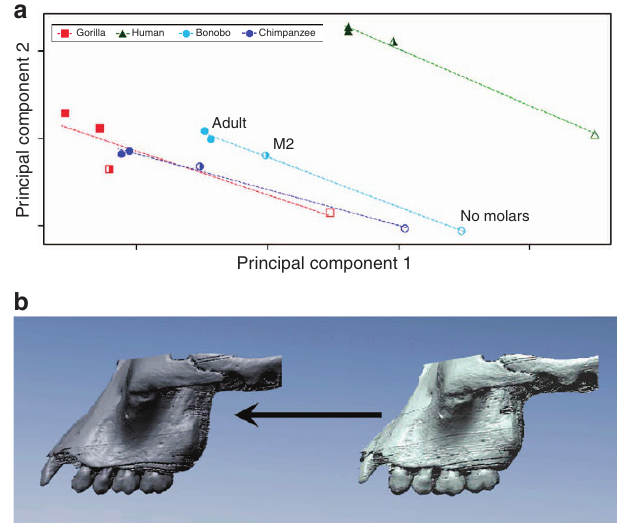
Figure 3 | Ontogenetic changes among the dentition, malar root and temporomandibular joint in 319 extant African apes and humans. ( a ) Principal component summary of shape differences, represented by mean configurations, among specimens with no molars (open symbols), M2 in occlusion (partially filled symbols) and adults (filled symbols). ( b ) Surface reconstruction of MH1 specimen rendered from down-sampled synchotron scans (right) and hypothetical adult morphology of MH1 generated using a male chimpanzee developmental trajectory